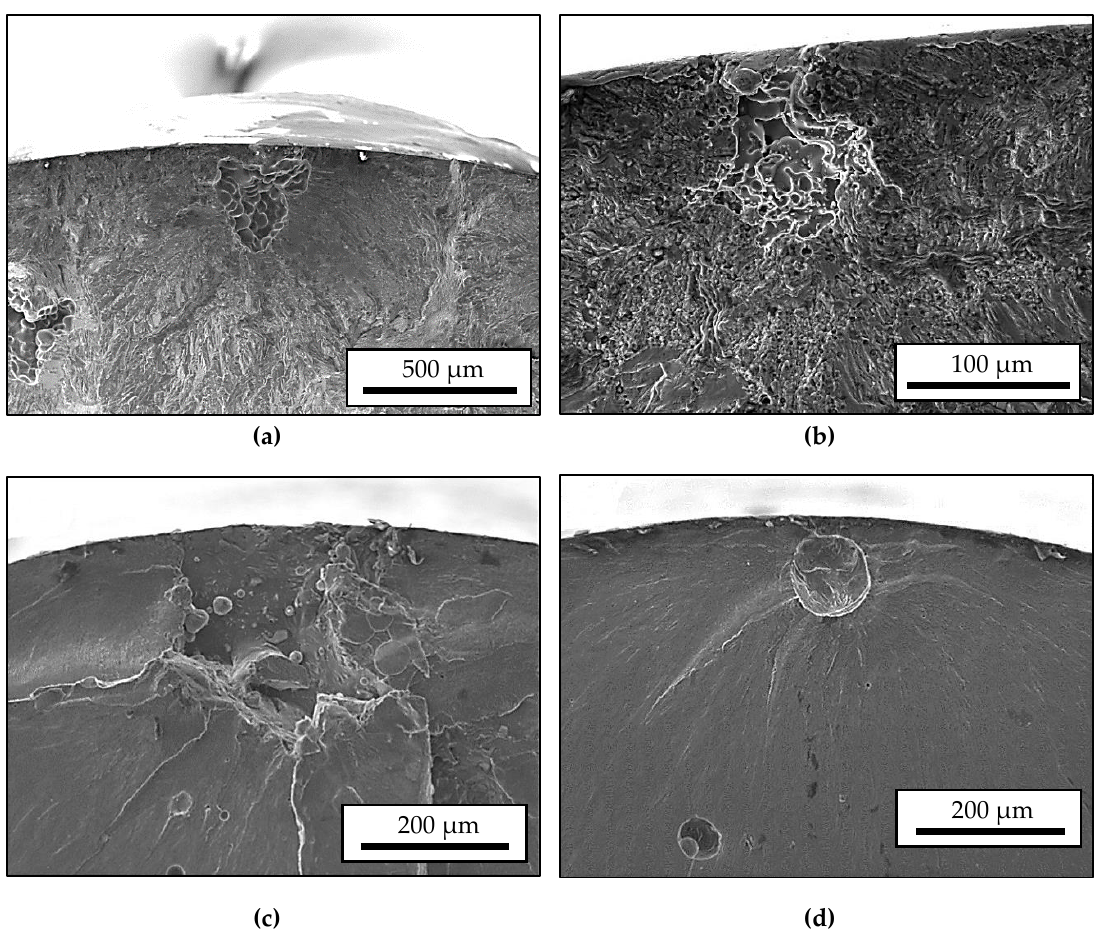
Figure 8. Fractographic identification of crack initiation side for ( a ) DC-1 at 140 MPa and N f = 1.1 · 10 5 , ( b ) DC-3 at 140 MPa and N f = 2.8 · 10 5 , ( c ) AM-1 at 70 MPa and N f = 1.6 · 10 6 and ( d ) AM-1 at 70 MPa and N f = 3.2 · 10 8 .